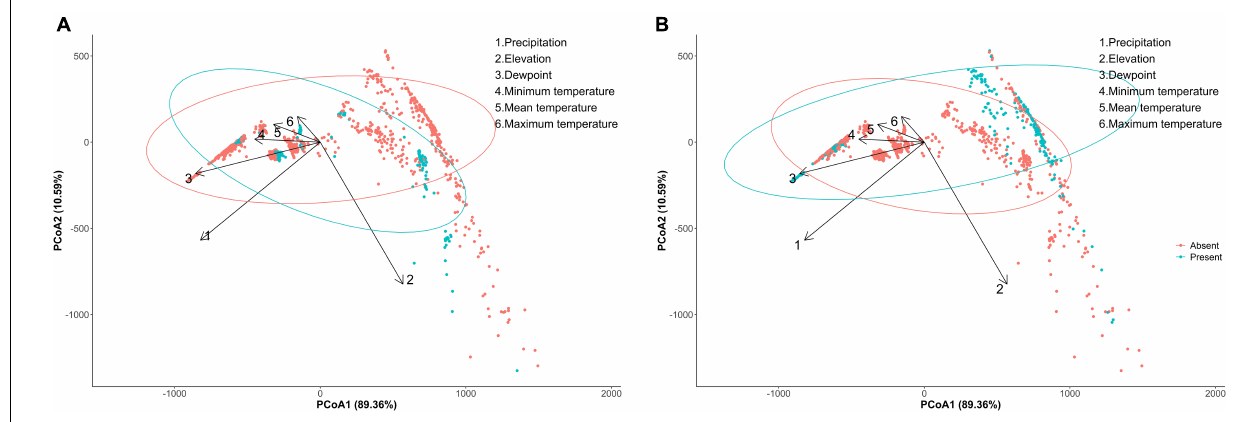
FIGURE 1 | Principal component analysis (PCoA) between incidence of (A) Culex pipiens , (B) Culex quinquefasciatus with overlaying environmental